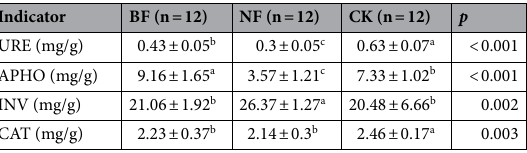
Table 3. ANOVA of soil enzymatic activities of different slash disposals in GSDFF.